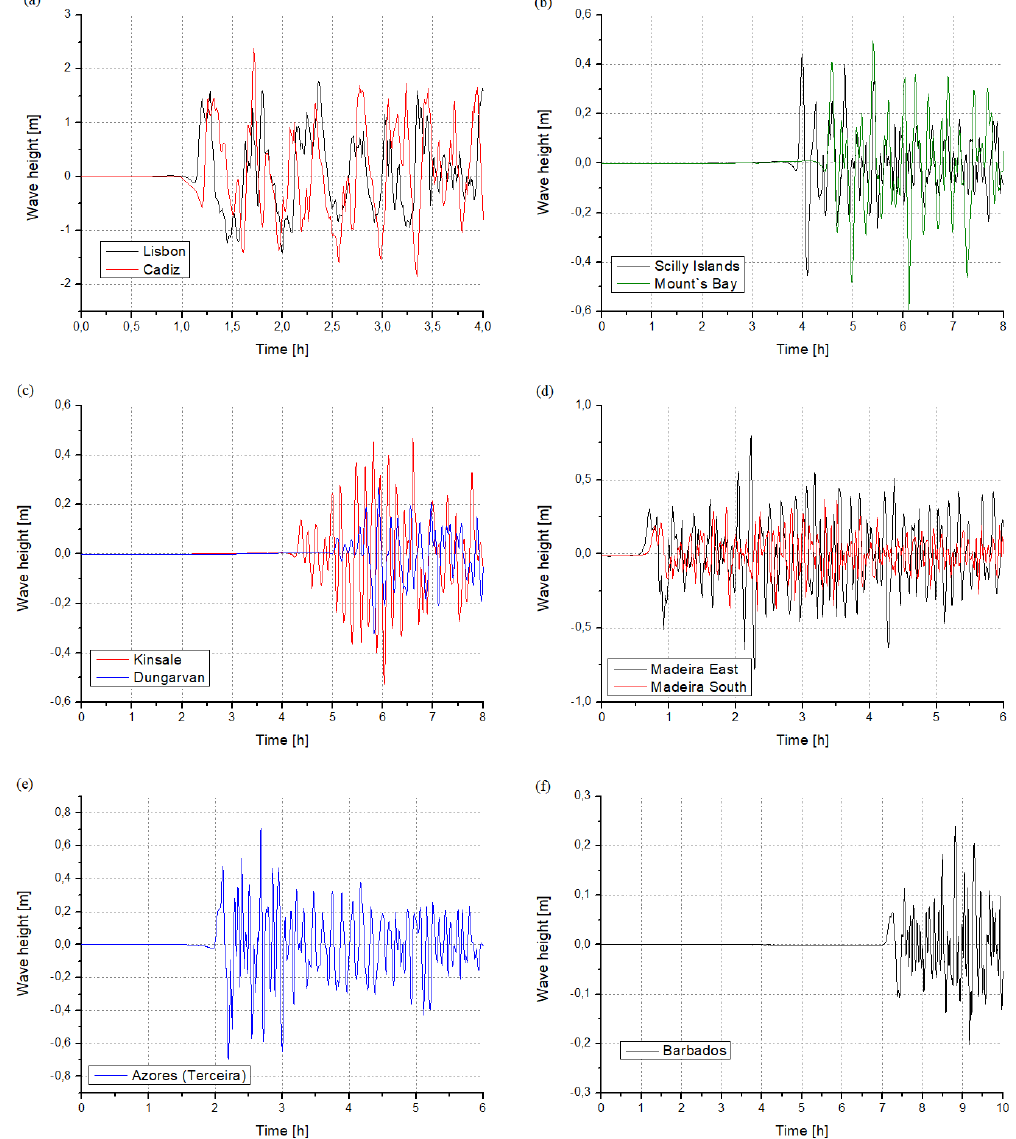
Figure 5. VTG records for hypothesis A-MS at the coordinates of the locations presented in Table 3.